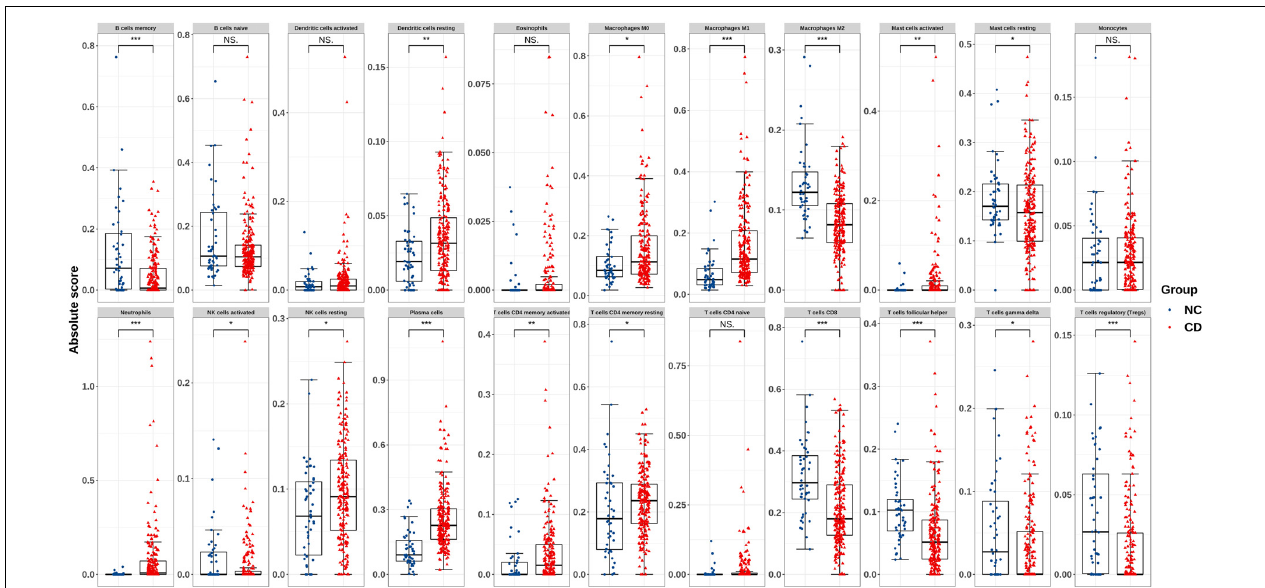
FIGURE 4 | Boxplot of comparisons of immune-cell proportion between CD patients and healthy controls in the derivation cohort. The red boxplot represents CD patients, and the blue boxplot represents healthy controls. The fraction of resting DCs, macrophages (M0 and M1), activated mast cells, and neutrophils were higher in CD patients, whereas the fraction of M2 macrophages, resting mast cells, and γδ T cells were lower in CD patients. The number of resting NK cells, plasma cells, CD4 memory T cells (activated and resting) were elevated in CD, whereas that of activated NK cells, memory B cells, CD8 T cells, follicular helper T cells, and Tregs was lower. * p < 0.05, ** p < 0.01, *** p < 0.001.